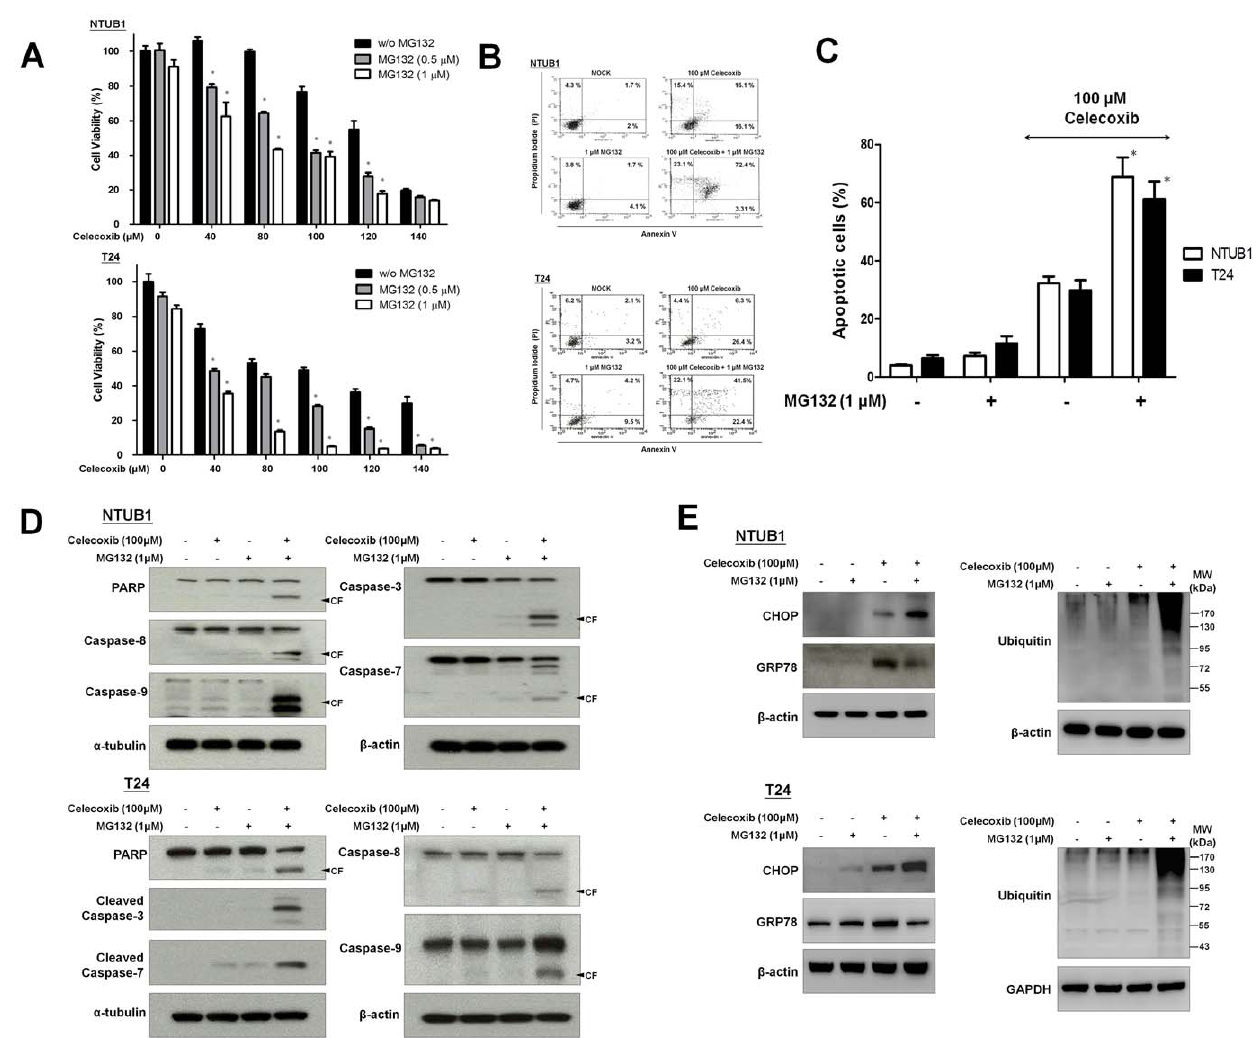
Figure 6. The combinative effect of celecoxib and MG132 on cell growth and apoptosis in NTUB1 and T24 cells. Cells were incubated in the presence of 100 m M celecoxib and MG132 (0.5 and 1 m M) individually or in combination. (A) Cell viability was measured by MTT assay. (B) Cells were stained with annexin V-FITC and PI for apoptosis analysis by FACS flow cytometry. (C) Quantitative analysis of total apoptosis (early and late) population was presented. (D) and (E) Cells were incubated in the presence of 100 m M celecoxib and MG132 (1 m M) individually or in combination. Cell lysates were harvested and analyzed by Western blotting with specific antibodies against, caspase-3, 7, 8, 9, PARP, CHOP, GRP78, and ubiquitin. In A and C, data are presented as means 6 SD of three independents experiments. * p , 0.05 as compared with celecoxib alone. In B and D, results shown are representative of at least three independent experiments.